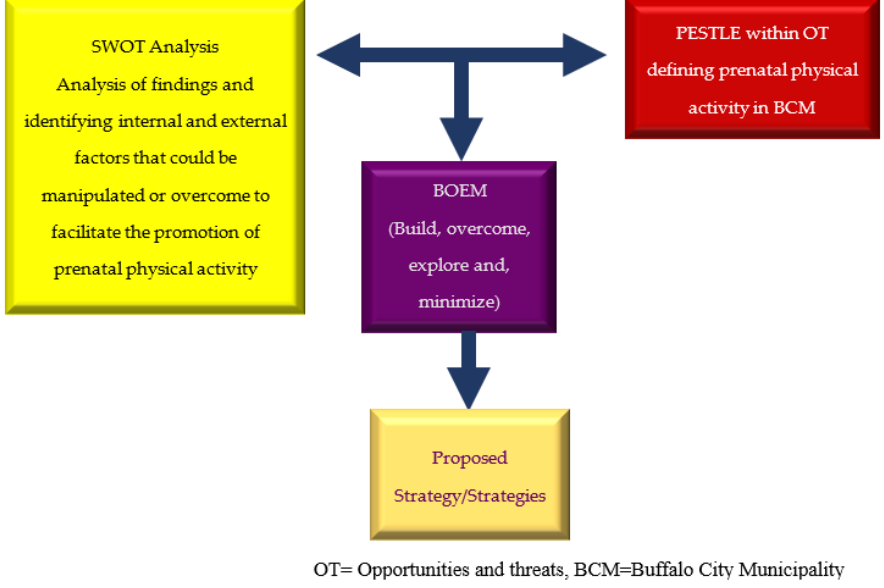
Figure 1. SWOT, PESTLE and BOEM strategies.